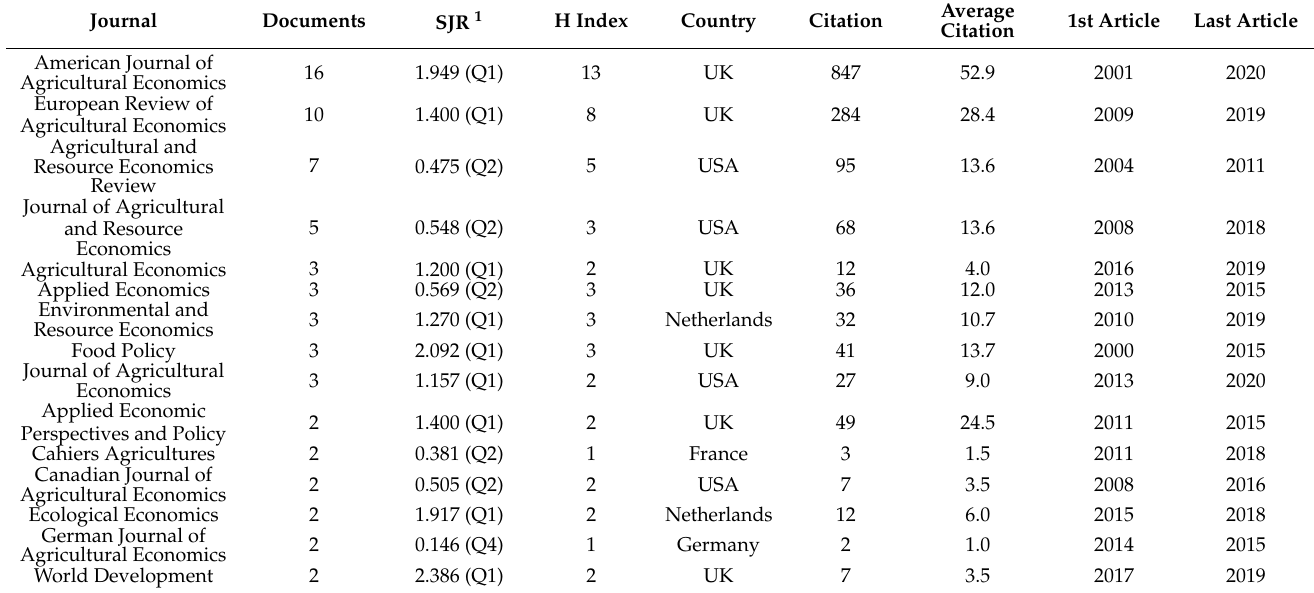
Table 3. Major characteristics of the most active journals related to EEA